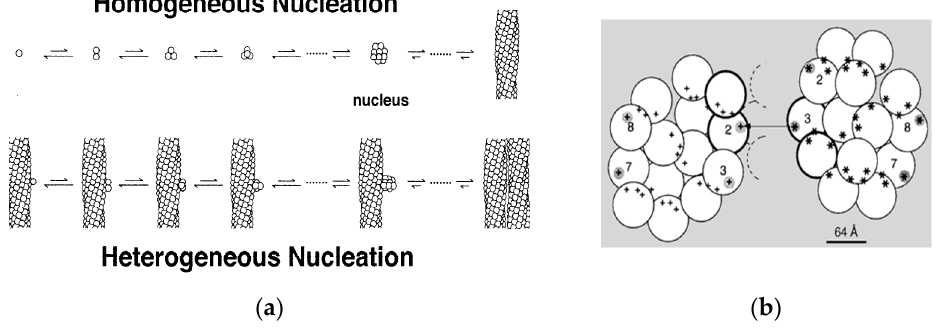
Figure 2. Kinetics and Mechanism. ( a ) The double nucleation mechanism [28]. Polymers can nucleate in homogeneous solution, or on the surface of pre-existing polymers. ( b ) The model of Mirchev and Ferrone [33]. Lateral contact sites on the polymer surface provide the template for heterogeneous nucleation by providing both donor and acceptor regions. This model has been experimentally verified [34].